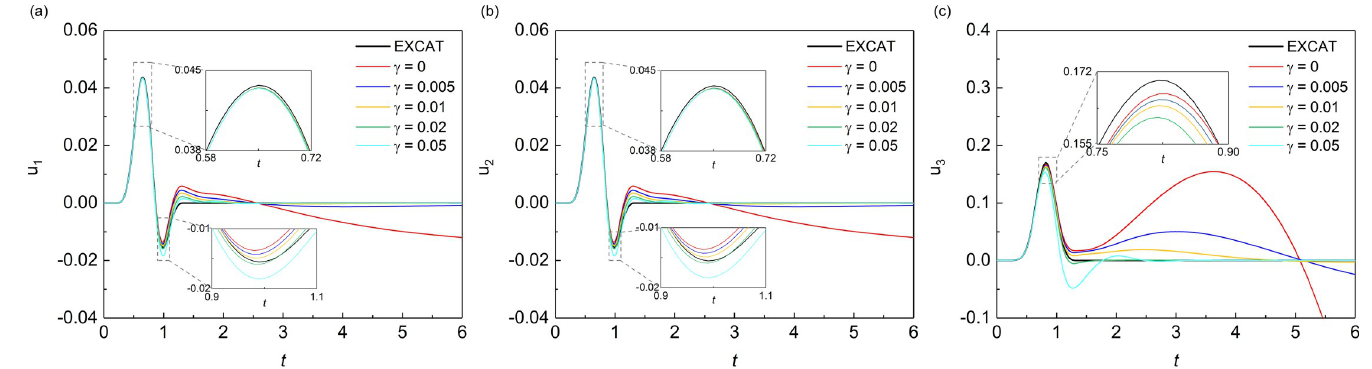
Fig 7. Displacement time-histories of observation point A .